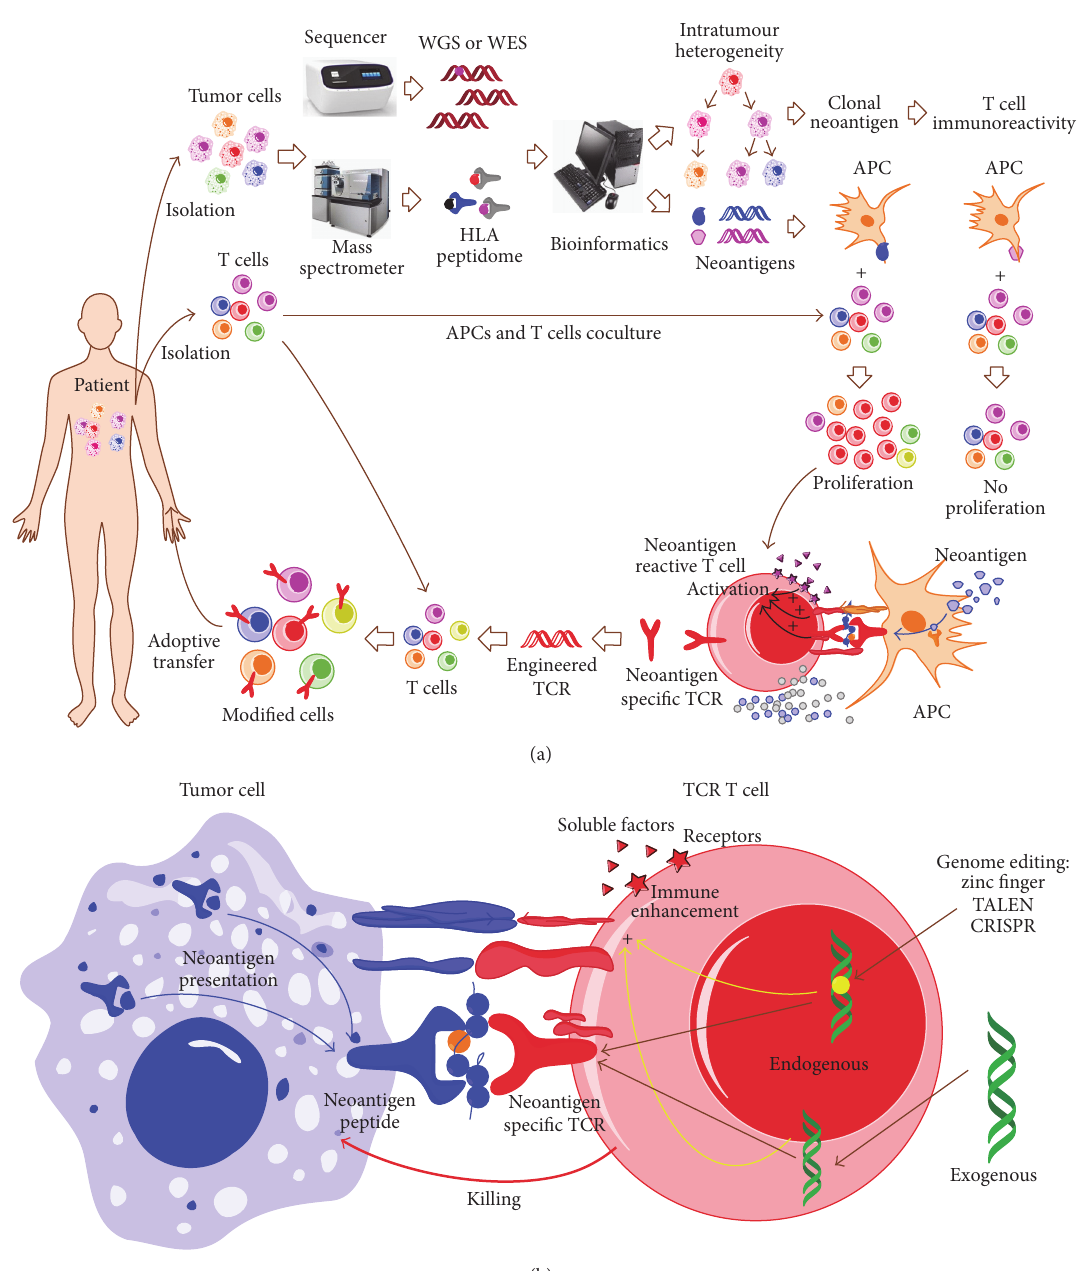
Figure 3: Identification of neoantigens and engineered neoantigen-specific TCR-T-cell-based adoptive immunotherapy in hematological malignancies. (a) Schematic procedures of TCR-T-cell-based adoptive immunotherapy. Both tumor cells and tumor-infiltrating lymphocytes (TIL) are isolated from a patient with hematological malignancies, respectively. The isolated tumor cells are subsequently subjected to